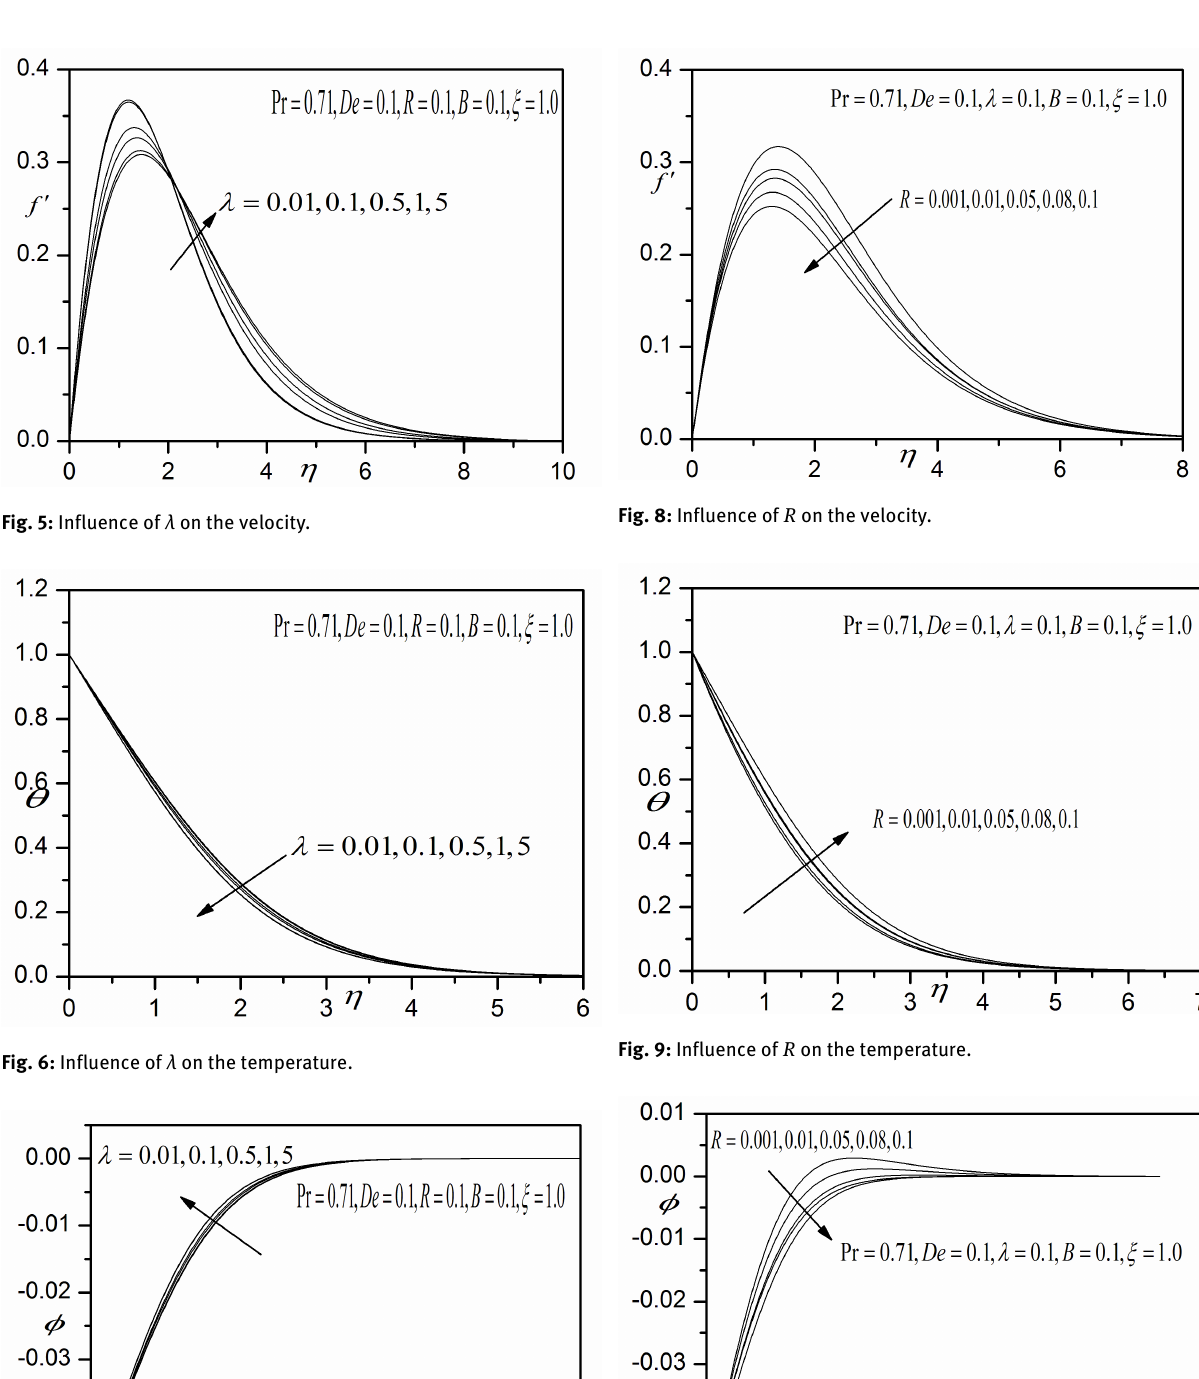
Fig. 7: Influence of λ on the angular velocity.